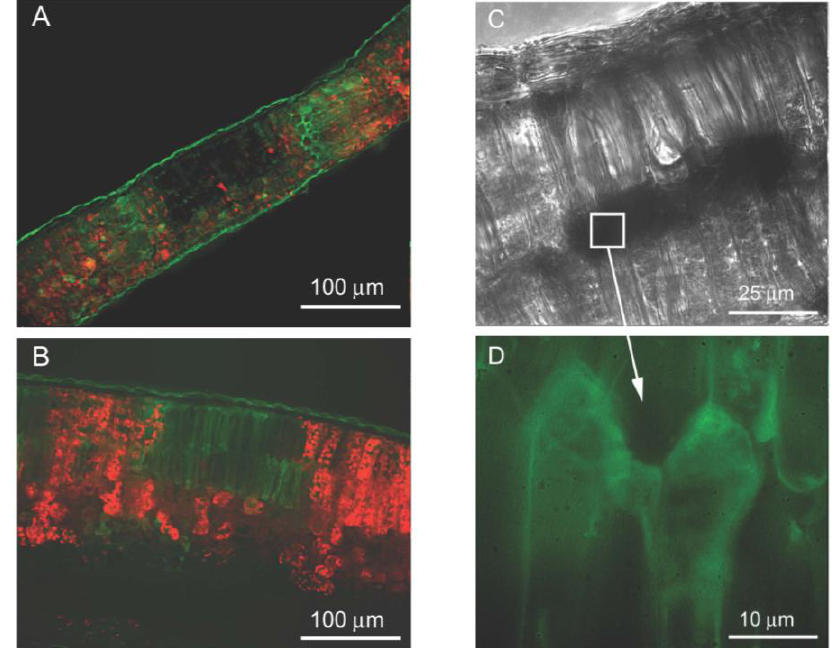
FIGURE 4. Autofluorescence images obtained by merging two bands of blue-excited (436 nm) monochrome images recorded at 546 and 680 nm, colored in green and red, respectively, for a beech (A) and a poplar (B) leaf cross-section. (C) Transmitted light image recorded at 546 nm from an injured area of a poplar leaf cross-section. (D) Green-yellow autofluorescence at the interface between the first and second palisade layers, as indicated in (C)